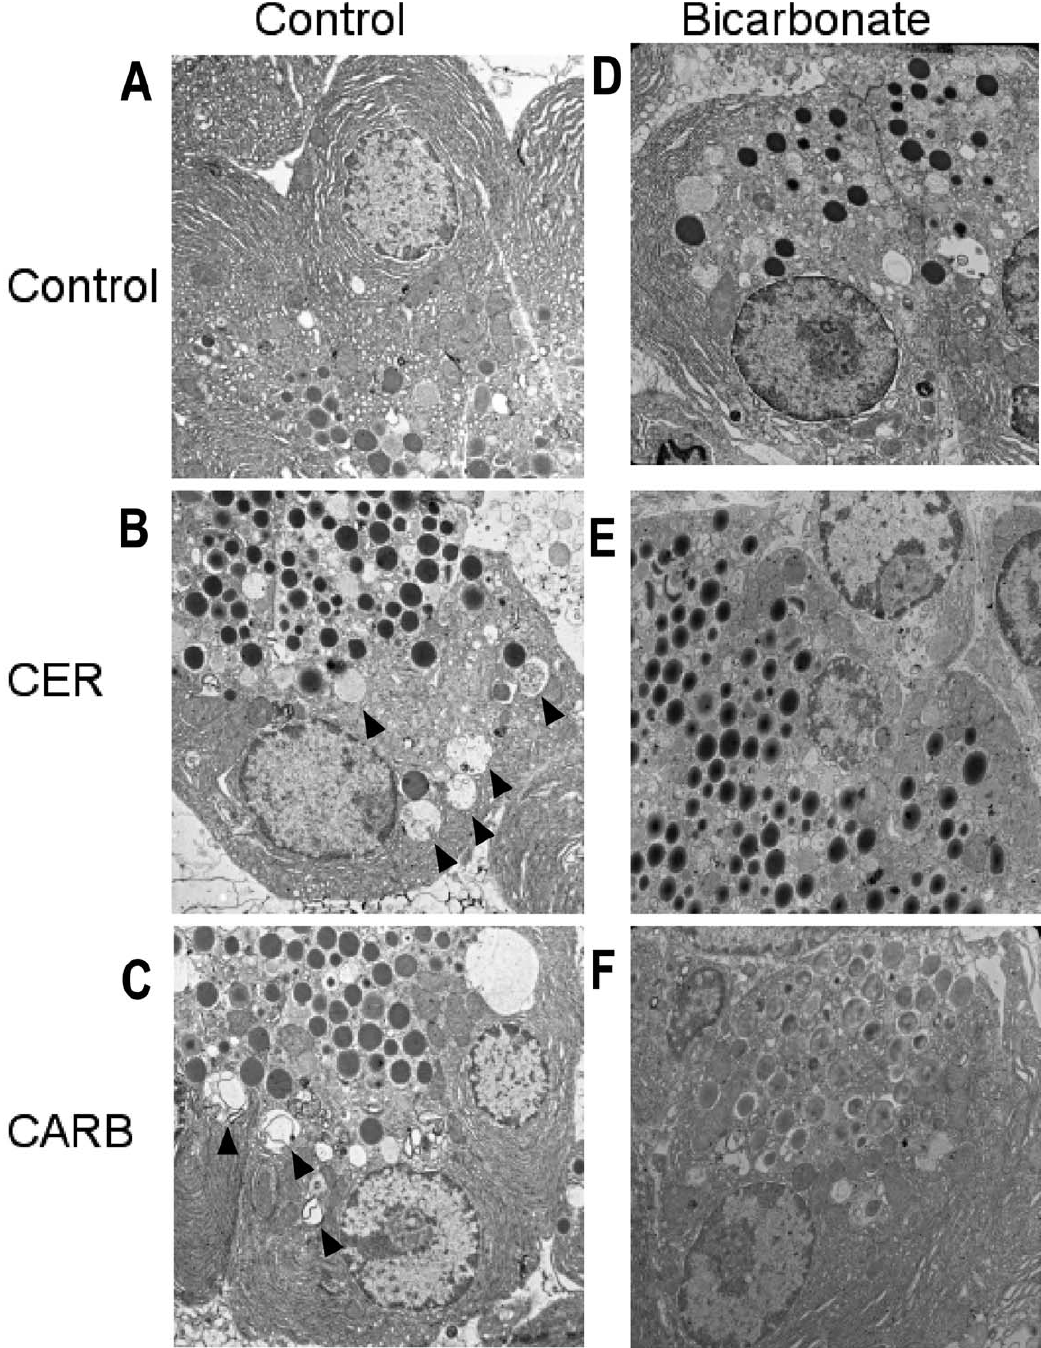
Figure 11. Bicarbonate treatment reduces acinar cell cytosolic vacuoles induced by hyperstimulation. Acini were treated with or without bicarbonate 25 mM either alone or in the presence of either CER 100 nM or CARB 1 mM for 1 hour. Cells were collected and fixed in PLP fixative followed by embedding in EPON. Sections were cut and examined via EM. Control (A), CER (B), CARB (C), Bicarbonate (D), CER + Bicarbonate (E) and CARB + Bicarbonate (F). Each is a representative photograph. Vacuoles are indicated by arrowheads.